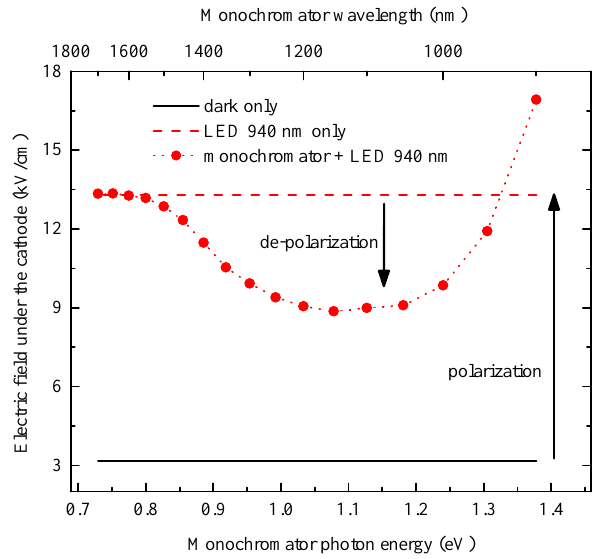
Figure 3. Infrared spectral scanning (IRSS) of the electric field under the cathode of planar detector Sample 1 biased at 500 V measured by the cross-polarizer technique based on the Pockels